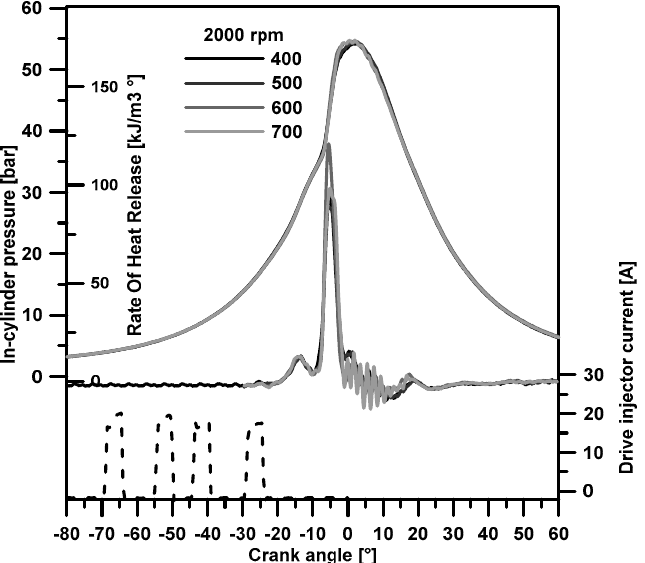
Figure 2. Histories of in-cylinder pressures, rates of heat release, and drive injector current at 2000 rpm and varying injection pressure, with four injections strategy (intake pressure fi xed at 2.4 bar).